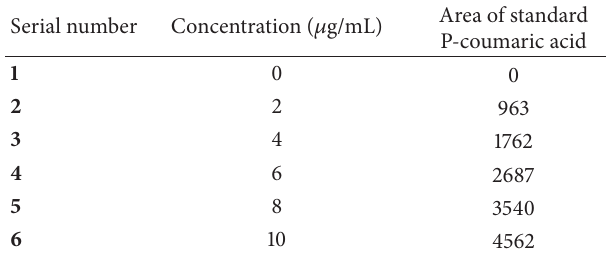
Table 4: Linearity analysis of HPLC method. Table 5: Determination of concentration of P-coumaric acid acid in methanolic extract of durva grass from its precision